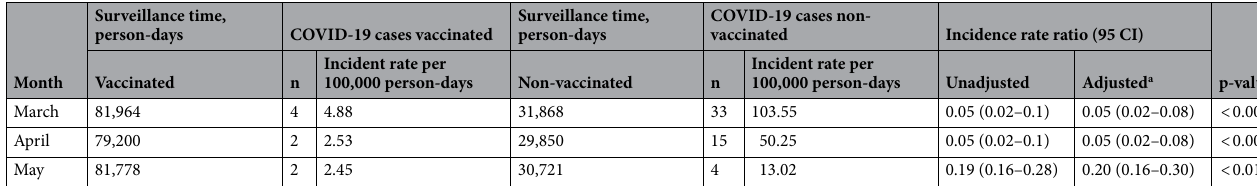
Table 5. Incidence of COVID-19 infection (95% Confidence Intervals CI) in hospital workers in Trieste from March 1, 2021 to May 31, 2021 in vaccinated and non-vaccinated workers. a Using Poisson regression, as reported in the M&M